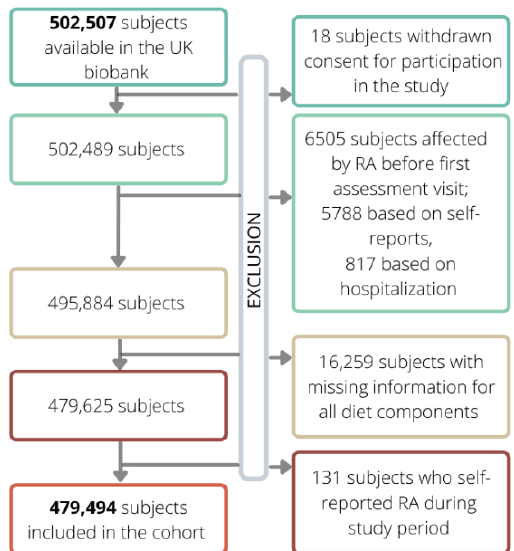
Figure 2. Flow chart of exclusion criteria which led to the definition of the final cohort from the initial one (shown in bold).